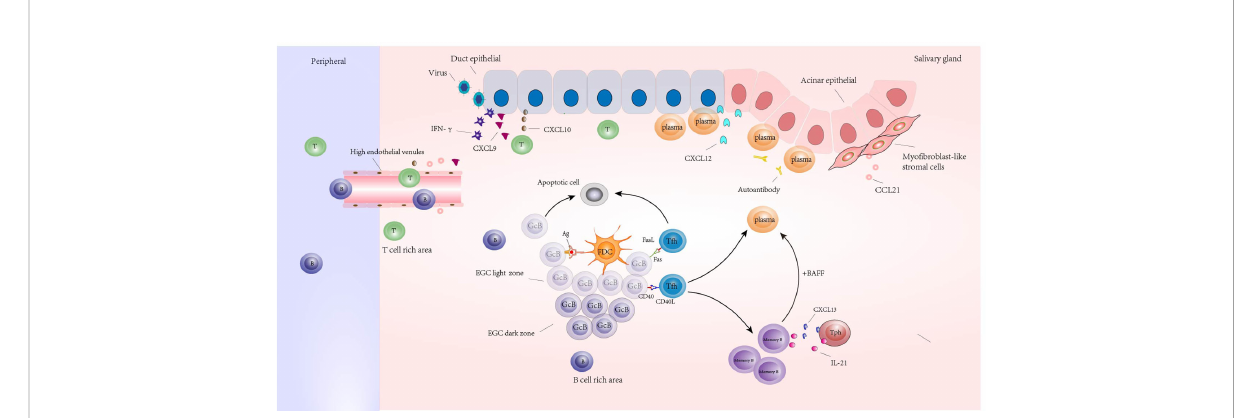
FIGURE 1 Ectopic lymphoid structures (ELSs) formed around the glands in the salivary glands of a patient with Sjogren ’ s syndrome. Its core is the ectopic germinal center (EGC), including the bright and dark regions; Germinal center B cells (GcB) were screened by follicular dendritic cells (FDC) in the bright region. The GcB cells that did not receive antigen presentation were apoptotic, and the GcB cells that received antigen presentation were transformed into memory B cells and plasma cells under the assistance of follicular helper T cells (Tfh) or were regulated by Tfh cells to undergo apoptosis. Under the regulation of IL-21 and CXCL13 produced by Tph, memory B cells were transformed into plasma cells under the combined action of BAFF and other factors. Plasma cells in fi ltrated around ducts and acinar epithelial cells expressing CXCL12 and produced autoantibodies. There are B cell rich areas and T cell rich areas around EGC. High endothelial venules (HEVs) appear in the periphery of lymphoid aggregates in T cell-rich areas, and HEV formation is in fl uenced by CCL21 produced by myo fi broblast-like stromal cells; Under the stimulation of virus and other inducements, tissues expressed IFN- g and induced the release of CXCL9 and CXCL10; CXCL9 and CXCL10 promote the accumulation of peripheral T and B lymphocytes that enter the gland through HEV to the site of in fl